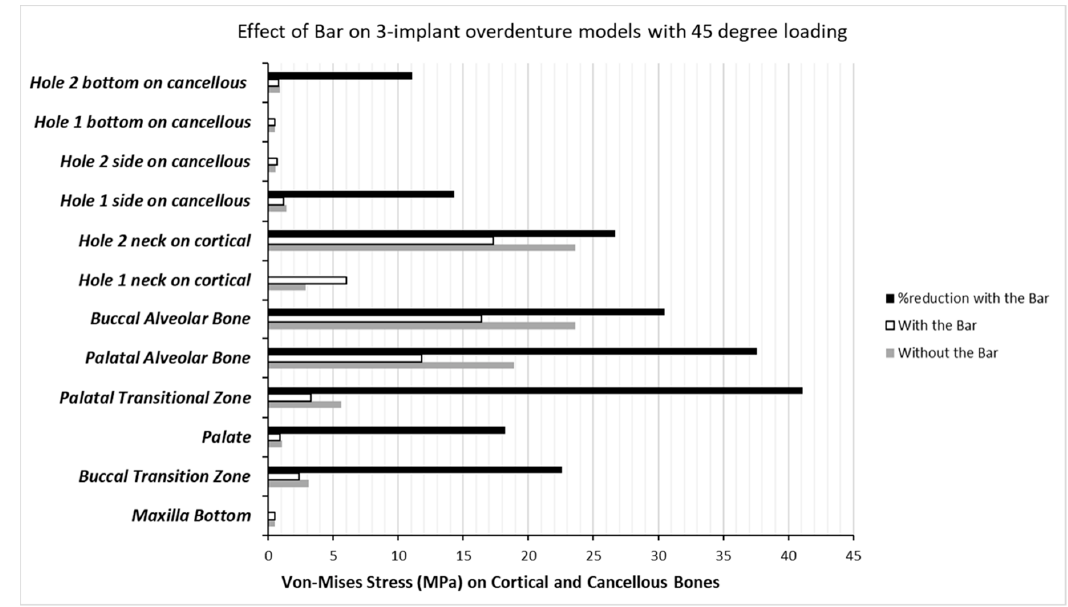
Figure 8. Effect of bar on three-implant overdenture models with 45-degree loading. Figure 8. E ff ect of bar on three-implant overdenture models with 45-degree